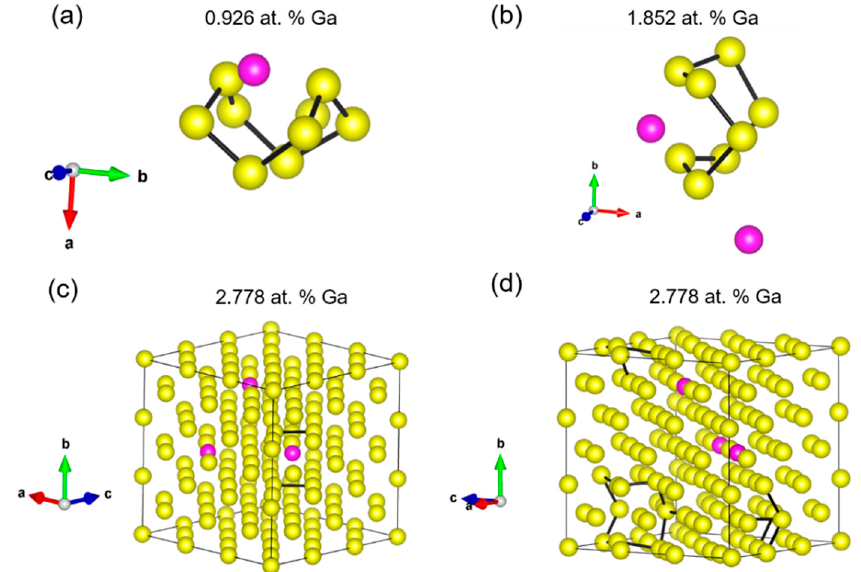
Figure 4. Distortion induced by a mono-vacancy at first nearest neighbor to a Ga atom for ( a ) 0.926, ( b ) 1.852, and ( c ) 2.778 at. % Ga, and ( d ) when the mono-vacancy is located at fourth nearest neighboring distance from the Ga for the 2.778 at. % Ga. For ( a ) and ( b ) only the distortion is shown, and the entire structure is shown for ( c ) and ( d ). Yellow and purple atoms are the Pu and Ga atoms, respectively, and Pu-Pu bonds >3.0 Å are shown in black.